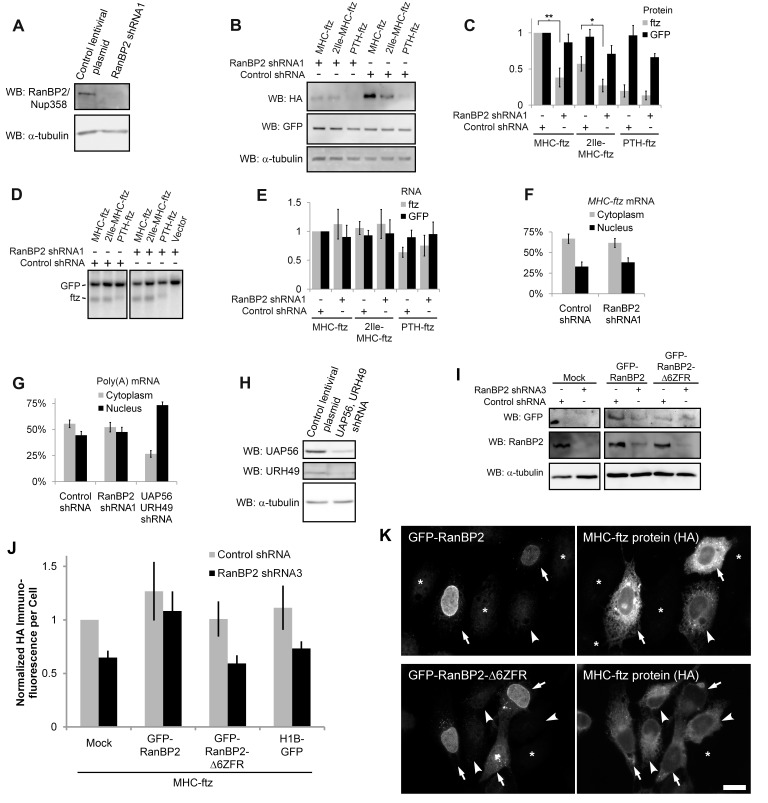
RanBP2 is required for ALREX-mediated translation enhancement.(A) U2OS cells were infected with lentivirus containing shRNA1 directed against RanBP2 or control virus. Four days post-infection, cell lysates were collected, separated by SDS-PAGE on a 6% acrylamide gel, and immunostained for RanBP2 or α-tubulin. (B–E) U2OS cells were infected with lentivirus that delivered shRNA1 against RanBP2 or control virus. Three days post-infection, cells were transfected with plasmids containing various ftz constructs and H1B-GFP. 18–24 h post-transfection the level of protein was analyzed by immunoblot (B, quantification in C) and mRNA by northern blot (D, quantification in E). Each bar represents the average and standard error of six independent experiments. *, p<0.025; **, p<0.01. (F) Three days post-infection, U2OS cells were transfected with plasmid containing MHC-ftz. 18–24 hr post-transfection the amounts of MHC-ftz mRNA found in the cytoplasm and nucleus was determined by FISH. One bar represents an average of three experiments, each of which consists of 20–30 cells. Error bars represent the standard deviation between the three experiments. (G) U2OS cells were treated with various lentiviruses. Four days post-infection, cells were fixed and stained for poly(A) mRNA by FISH. The average levels of poly(A) mRNA in the cytoplasm or nucleus were plotted. One bar represents an average of three experiments, each of which consists of 20–30 cells. Error bars represent the standard deviation between the three experiments. (H) UAP56 and URH49 were simultaneously depleted in U2OS cells by lentiviral mediated delivery of shRNAs. Four days post-infection, cell lysates collected, separated by SDS-PAGE, and immunostained for these two proteins and for α-tubulin. (I–K) U2OS cells were infected with lentivirus containing shRNA directed against the 3′ UTR of RanBP2 (shRNA3) or control virus. (I) Three days post-infection, cells were transfected with plasmids containing GFP-RanBP2, or GFP-RanBP2Δ6ZFR or without plasmid (“Mock”). After allowing expression for 48 h, cell lysates were collected and detected by immunoblot using antibodies against GFP, RanBP2, and α-tubulin. Note that the GFP-RanBP2 constructs do not contain the endogenous UTRs and are resistant to depletion by shRNA3. (J–K) Three days post-infection, cells were co-transfected with plasmids containing MHC-ftz and either GFP-RanBP2, GFP-RanBP2Δ6ZFR, or H1B-GFP and allowed to express for 48 h. Cells were immunostained using anti-GFP and anti-HA primary antibodies, and the appropriate fluorescent secondary antibodies. (J) For cells co-expressing GFP and MHC-ftz, the HA-immunofluorescence intensity was tabulated, averaged, and then normalized to the level of expression in mock, control shRNA-treated cells expressing MHC-ftz. Each bar represents the average and standard error between four independent experiments, each of which consists of 30–50 cells. Examples of cells depleted of endogenous RanBP2 with shRNA3 and expressing various GFP-RanBP2 constructs and MHC-ftz are shown in (K). Each row is a single field co-immunostained for GFP and HA. Note that cells expressing GFP-RanBP2 (top row, arrows), express higher levels of MHC-ftz than neighboring cells that express MHC-ftz alone (top row, arrowheads). In contrast, cells expressing GFP-RanBP2Δ6ZFR (bottom row, arrows) express about as much MHC-ftz protein as cells expressing MHC-ftz alone (bottom row, arrowheads). Un-transfected cells are denoted by asterisks. Scale bar = 20 µM.